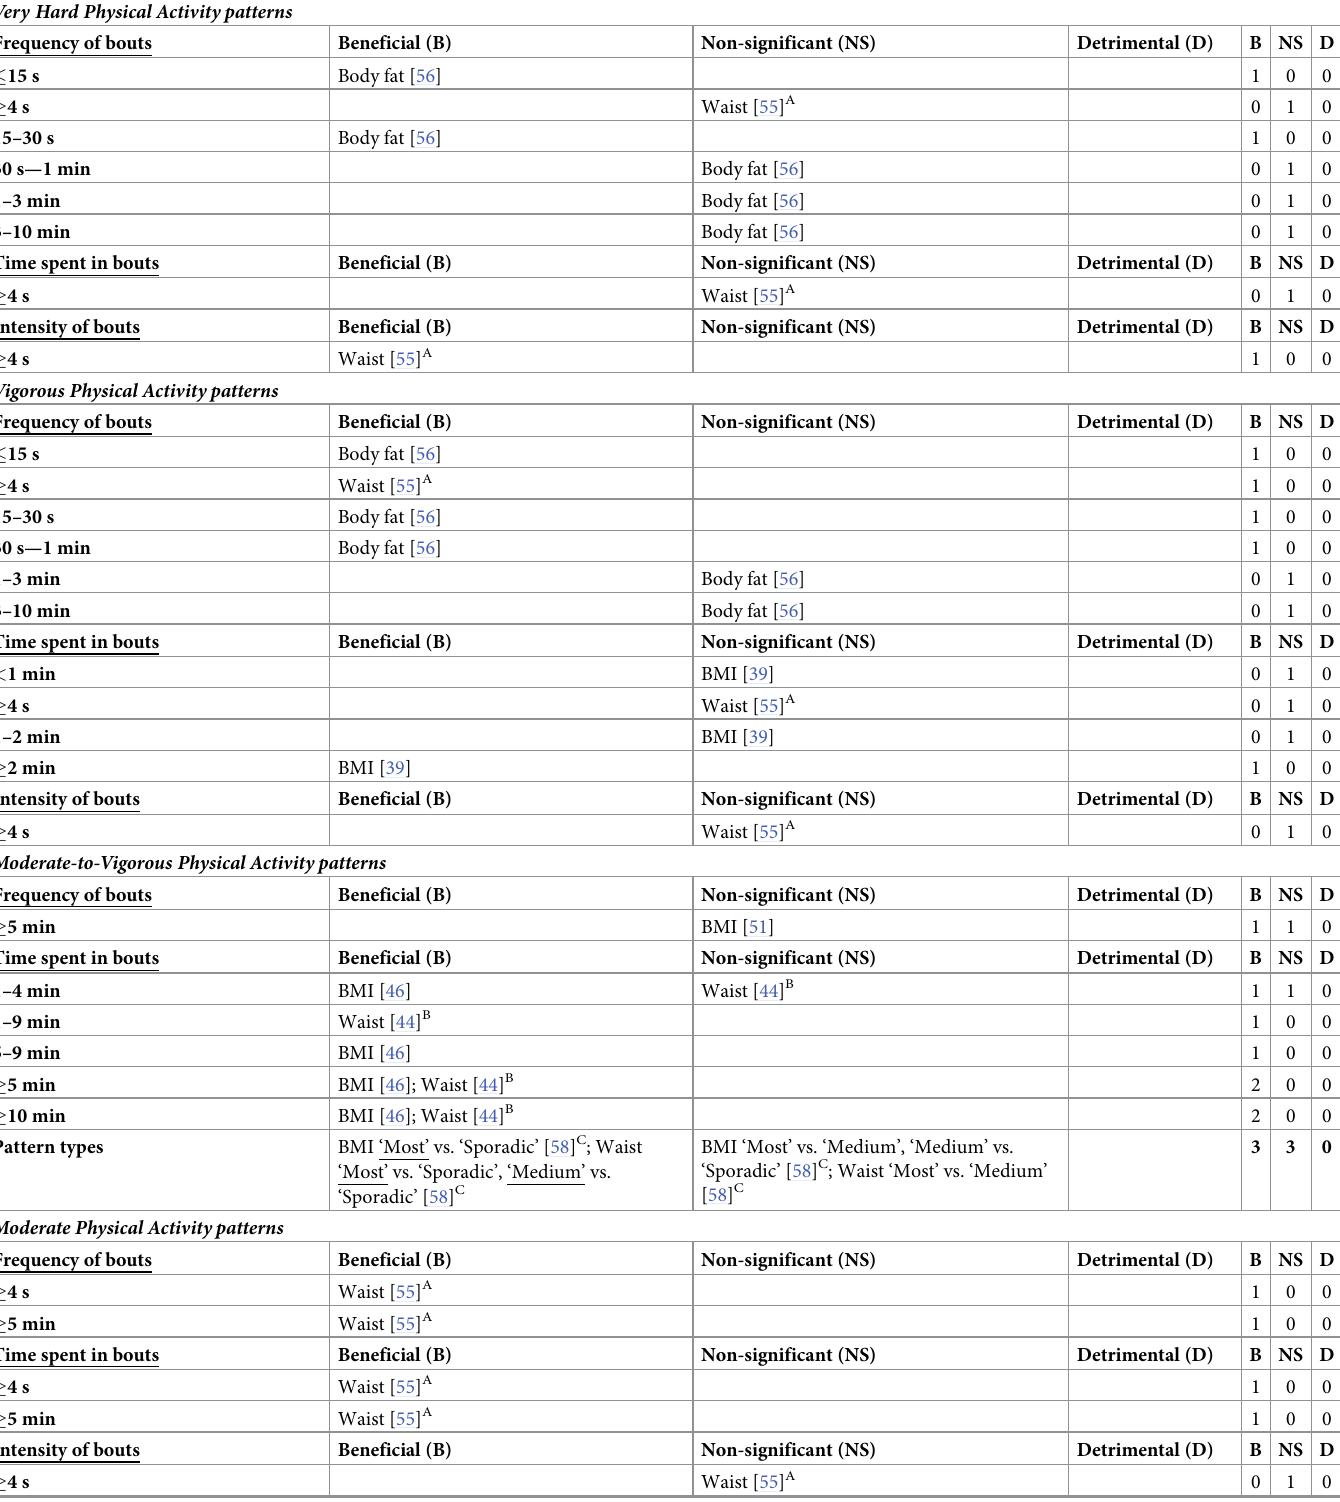
Table 1. Studies reporting beneficial, non-significant and detrimental associations of activity patterns with adiposity risk